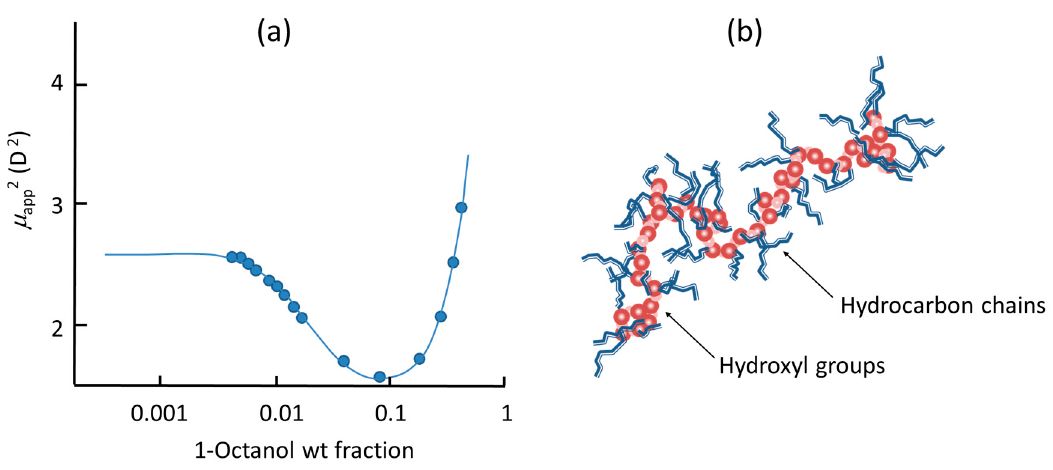
Figure 1. ( a ) Concentration dependence of the square of the dipole moment of 1-octanol (in n -hexane), after Campbell et al. [16]; ( b ) chain-like structure of clustered molecules in neat 1-octanol, after MacCallum et al. [39], showing interacting hydroxyl groups (oxygen—dark red, hydrogen—pink).